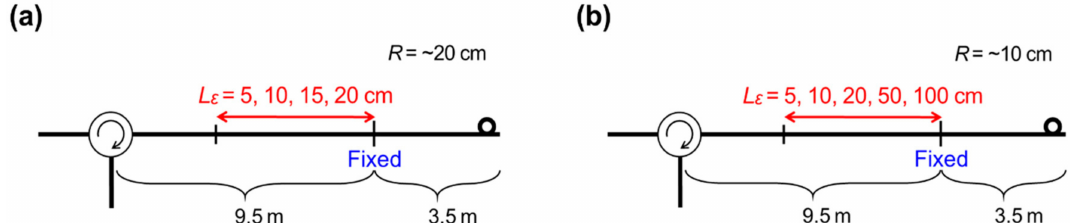
Figure 10. ( a ) Structure of an FUT with a relatively high spatial resolution (9.5 cm); and ( b ) structure of an FUT with a relatively low spatial resolution (19.6 cm). Reproduced with permission from [60]. Copyright (2016)